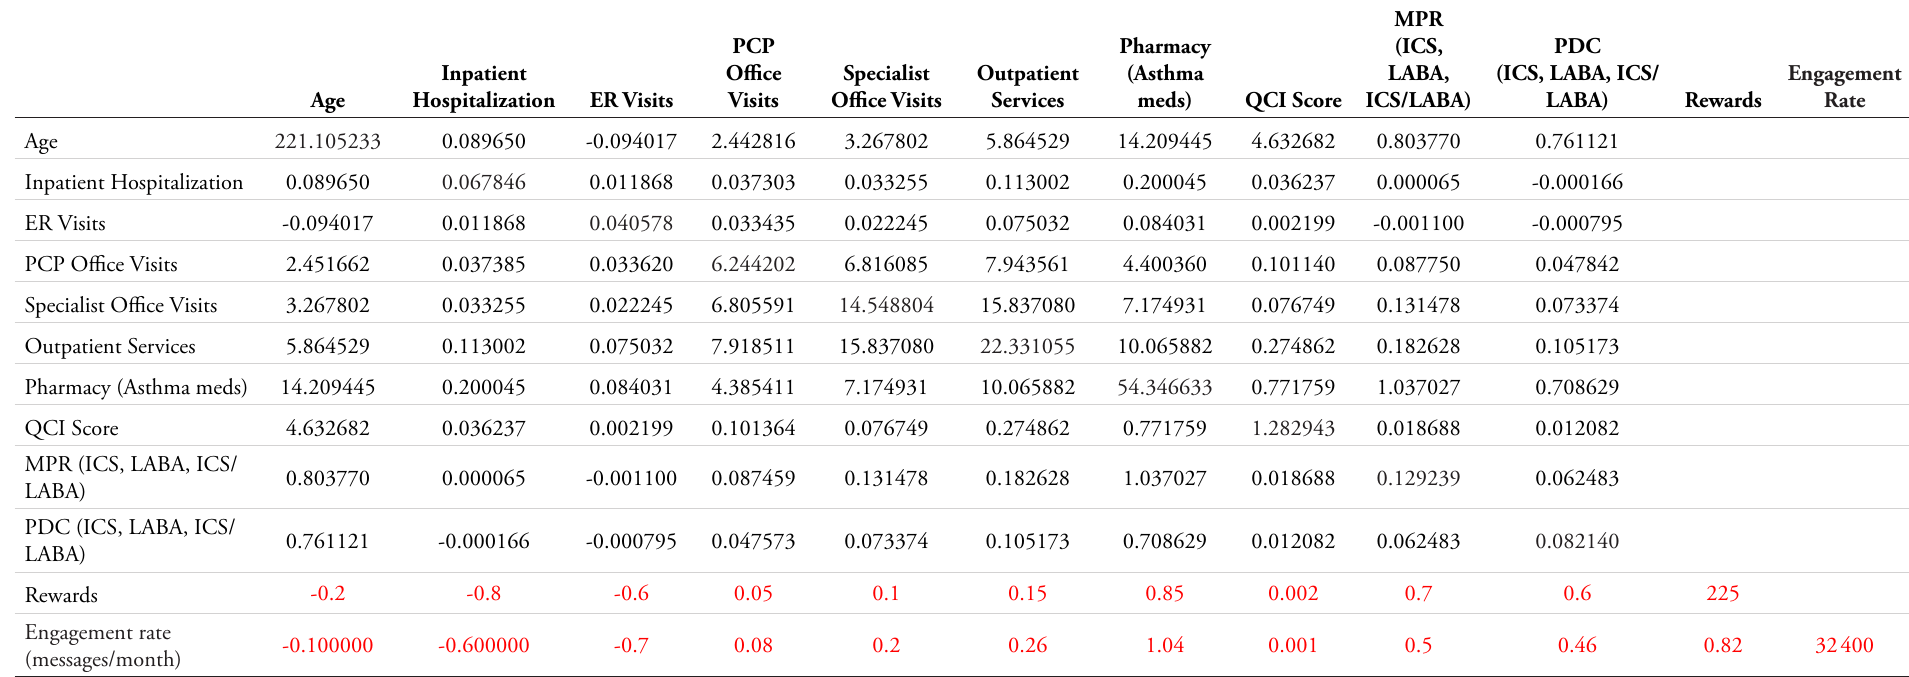
Table 3. Variance and Covariances of HIRD and Lateralized Data